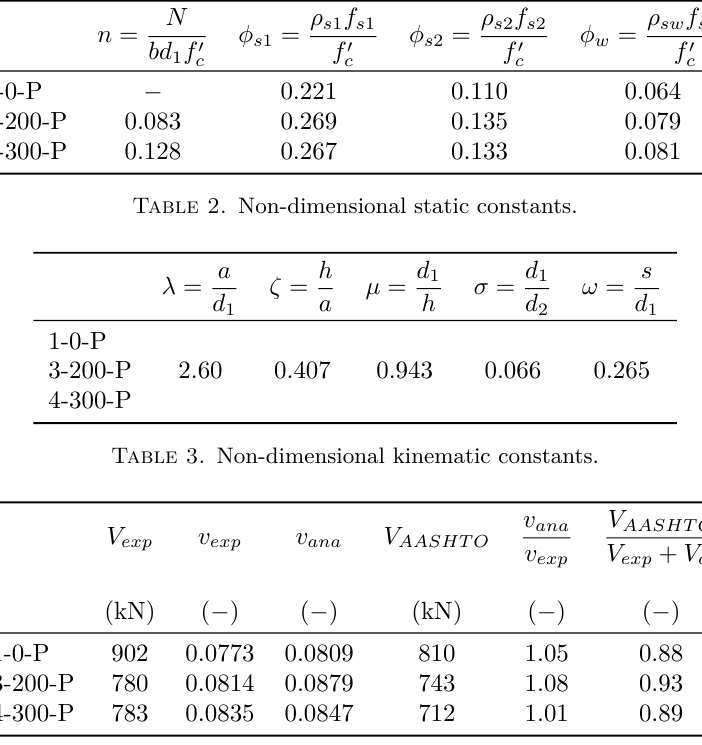
Table 4. Accuracy of the developed